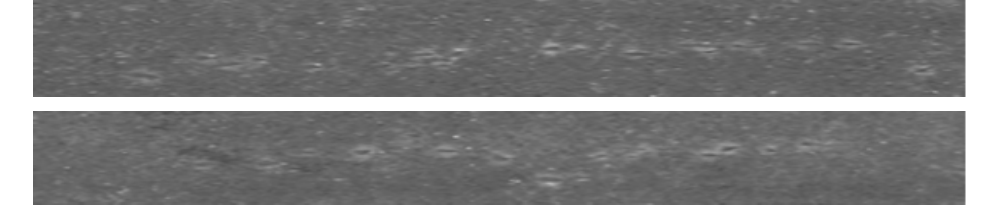
Figure 13. Well-recognized roll marks.